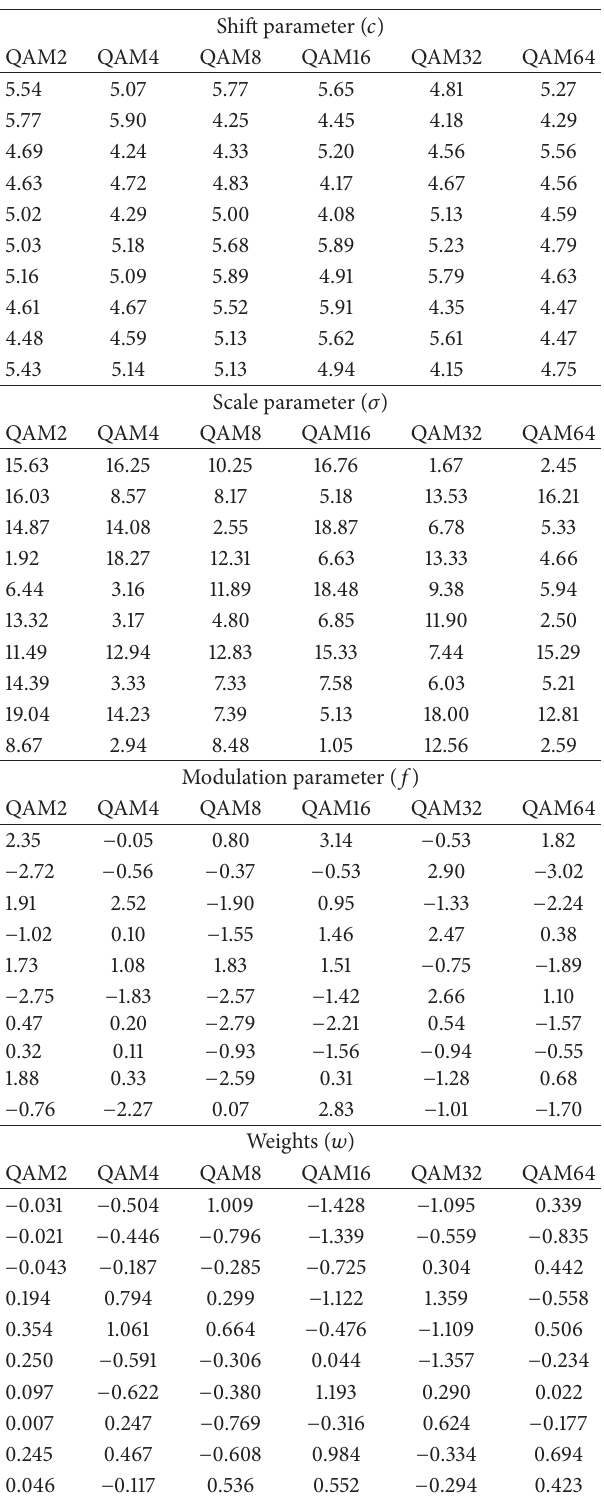
Table 3: Updated Gabor filter atom parameters and weights for QAM